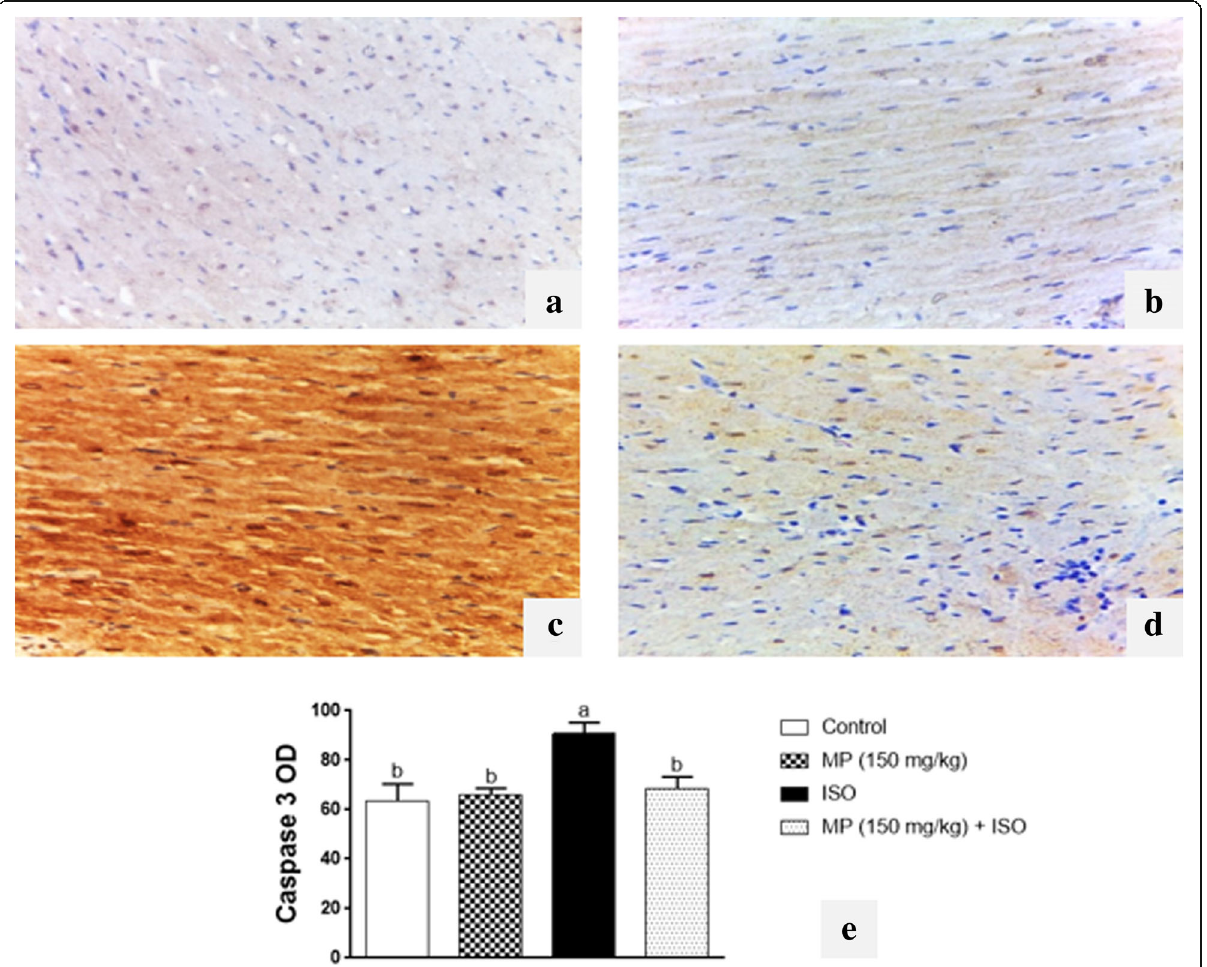
Fig. 6 Immunohistochemical analysis of caspase 3 in heart sections (magnification × 400). a Control group showing minimal degree of caspase 3 expression. b MP group showing minimal caspase 3 expression. c ISO-intoxicated group showing extensive heavy caspase 3 expression. d MP- pretreated group showing mild caspase 3 expression. e Quantitative image analysis for caspase 3 immunohistochemical staining expressed as optical densities (OD) across 10 different fields for each rat section. Data are presented as mean ± SD ( n = 10); a or b: significantly different from control or ISO groups respectively at P < 0.05 using one-way ANOVA followed by Tukey as post hoc test. MP methyl palmitate, ISO